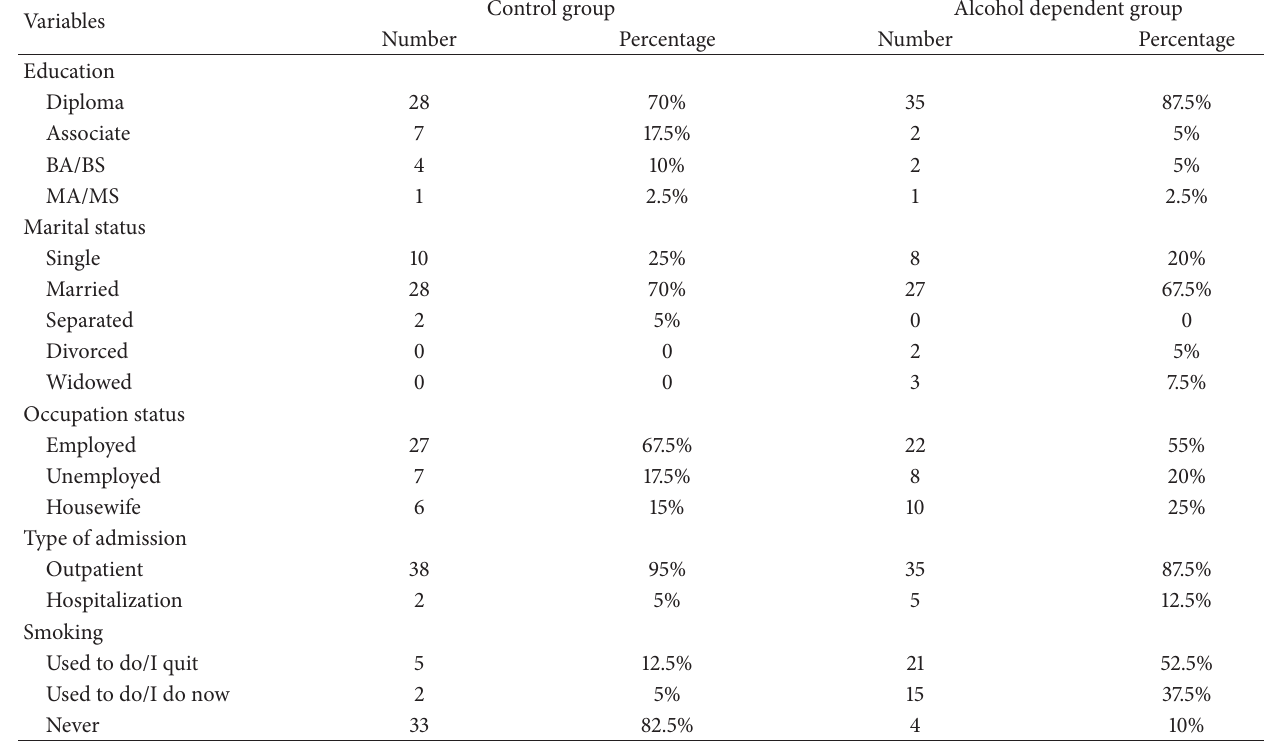
Table 1: Demographic variables in control and alcohol dependent groups.